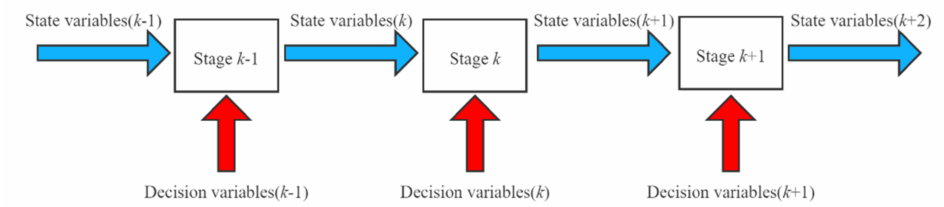
Figure 6. Block diagram of the energy management multi-stage decision-making